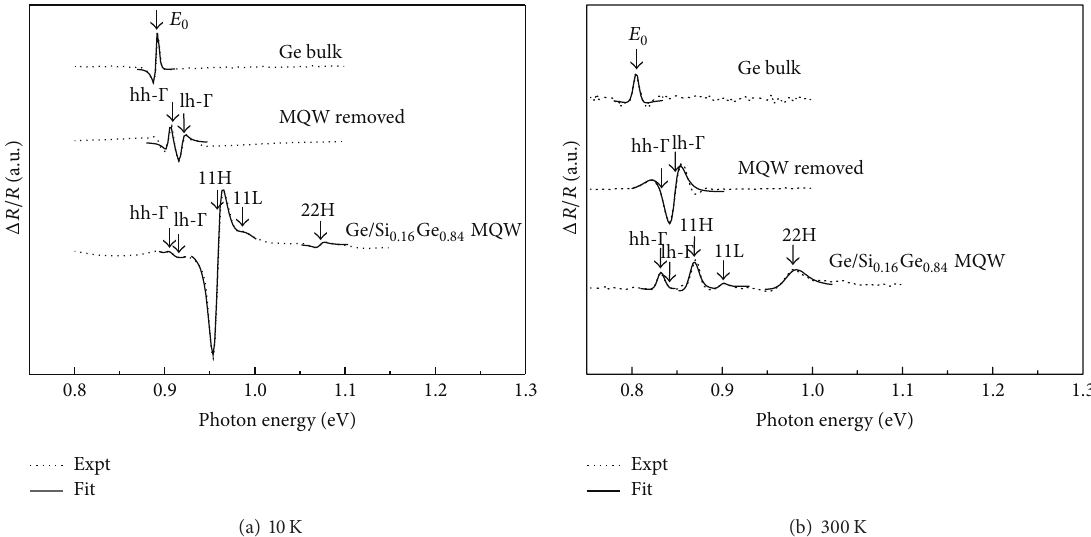
Figure 1: The experimental PR spectra (dashed curves) of Ge bulk, MQW removed sample, and Ge/Si 0.16 Ge 0.84 MQW structure at (a) 10 K and (b) 300 K. The solid lines are fit to the first derivative of Lorentzian line-shape functional form. The obtained various transition energies are indicated by the